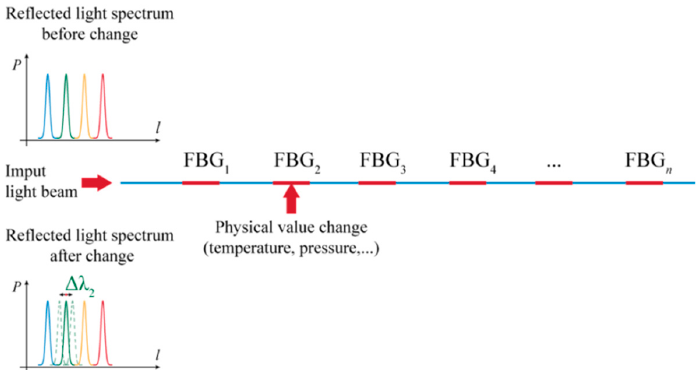
Figure 6. Principal representation of the indirectly distributed fiber sensor and its functioning.